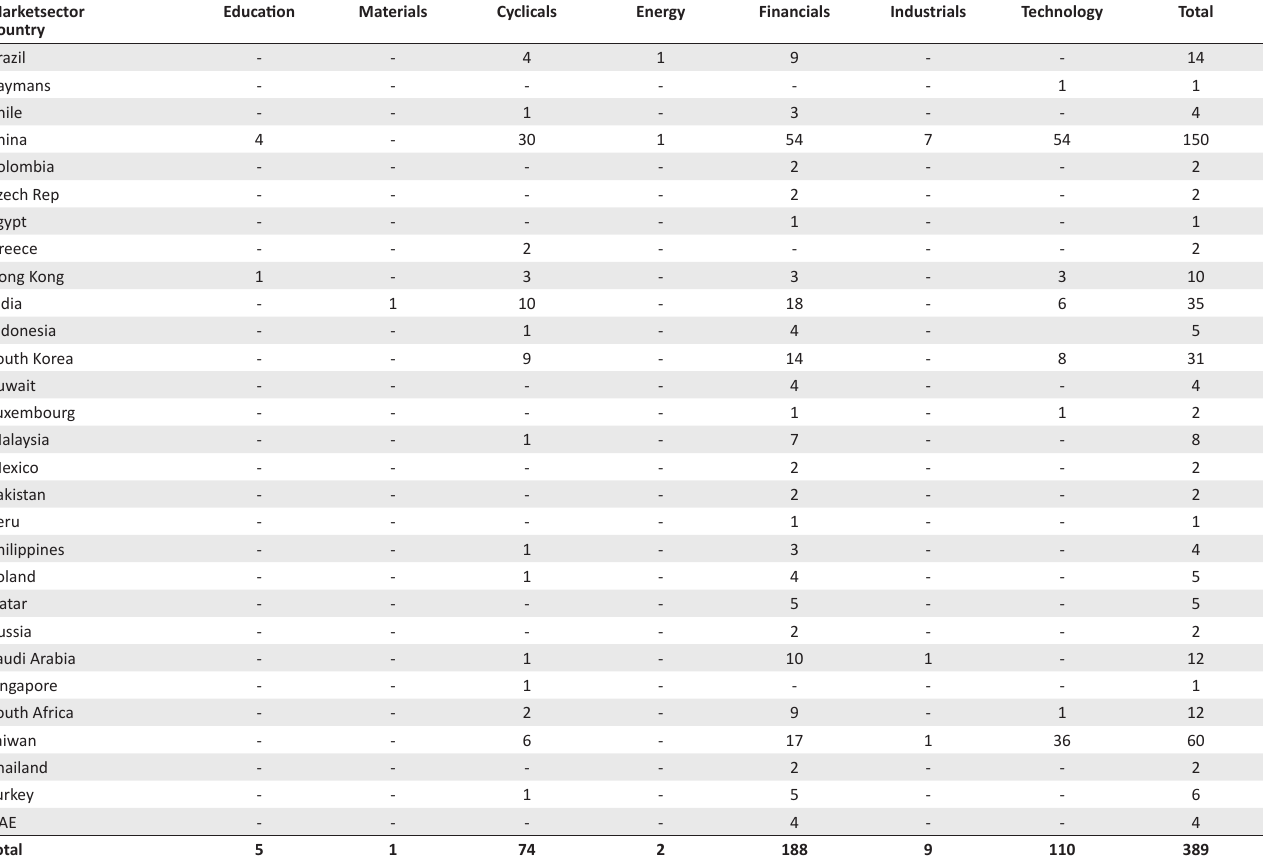
TABLE 2: Data summary by country and market sector. Marketsector